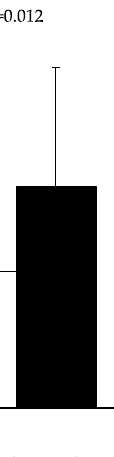
Figure 2. Concentration of preferred sucrose solution chosen by participants after the sleep curtailment condition and control sleep condition. Black bars represent the sleep curtailment condition and white bars represent the control sleep condition. The black and white bars and error bars show the mean and standard deviation,